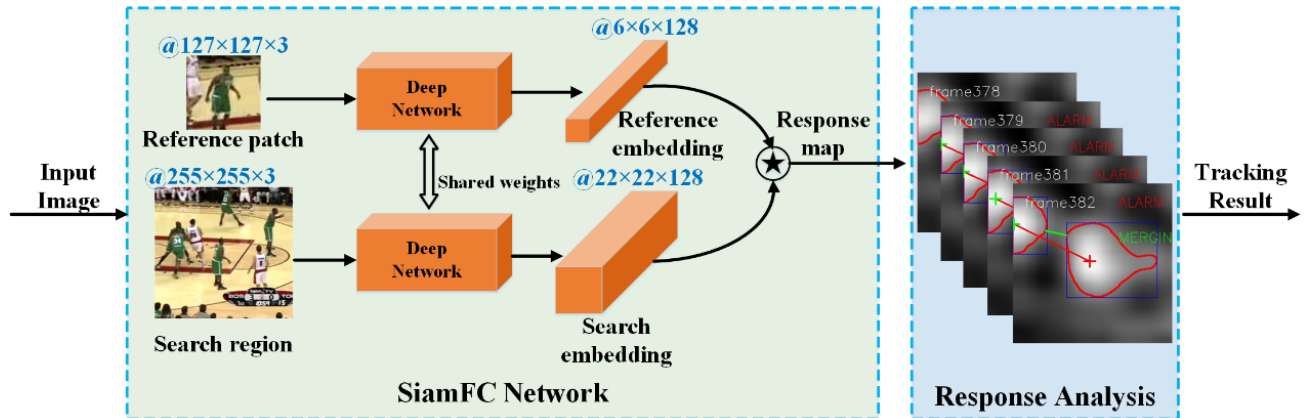
Figure 1. Overview of the proposed tracking method.